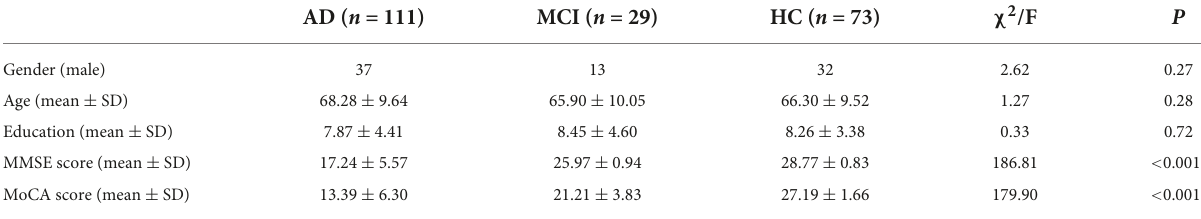
TABLE 1 Demographic and clinical information.